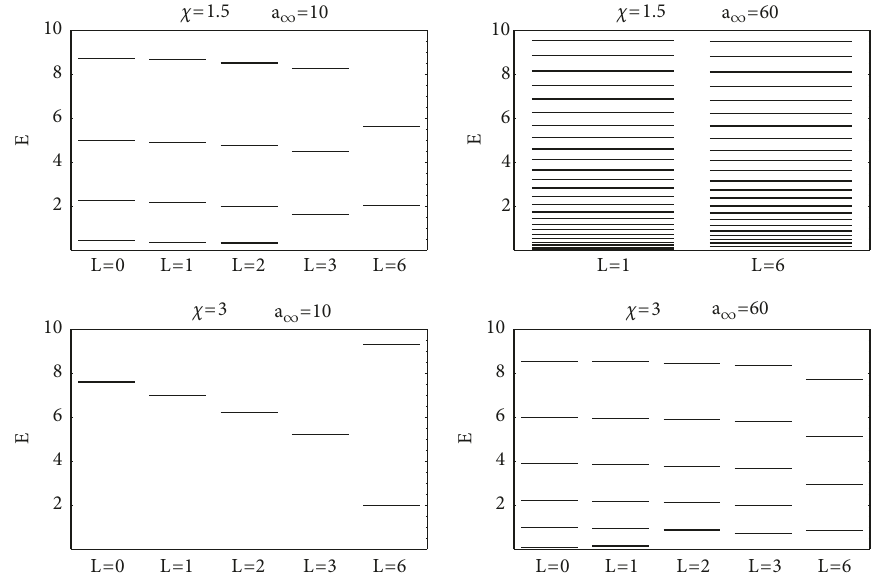
Figure 7: Energy spectrum 𝐸 for the linear dipole problem with boundary conditions on the volume from Eq. (47) for two dipole strength, 𝜒 = 1.5, 3 and two volume radii, 𝑅 = 𝑎 = 10,60 . ∞